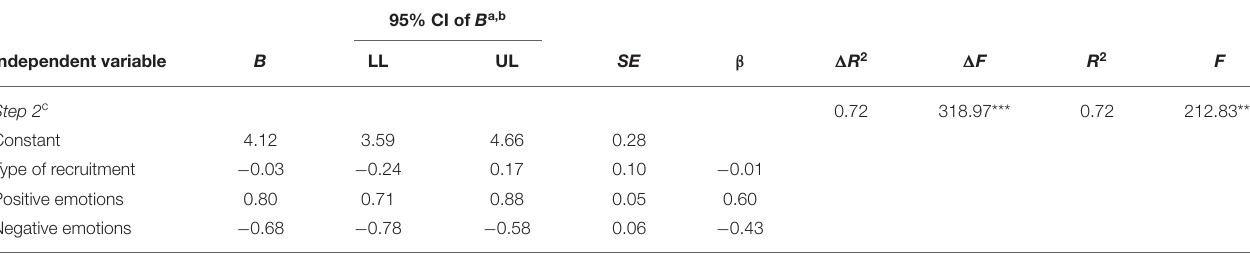
TABLE 8 | Regression coefficients of emotions toward algae-based biofuel on acceptability of algae-based